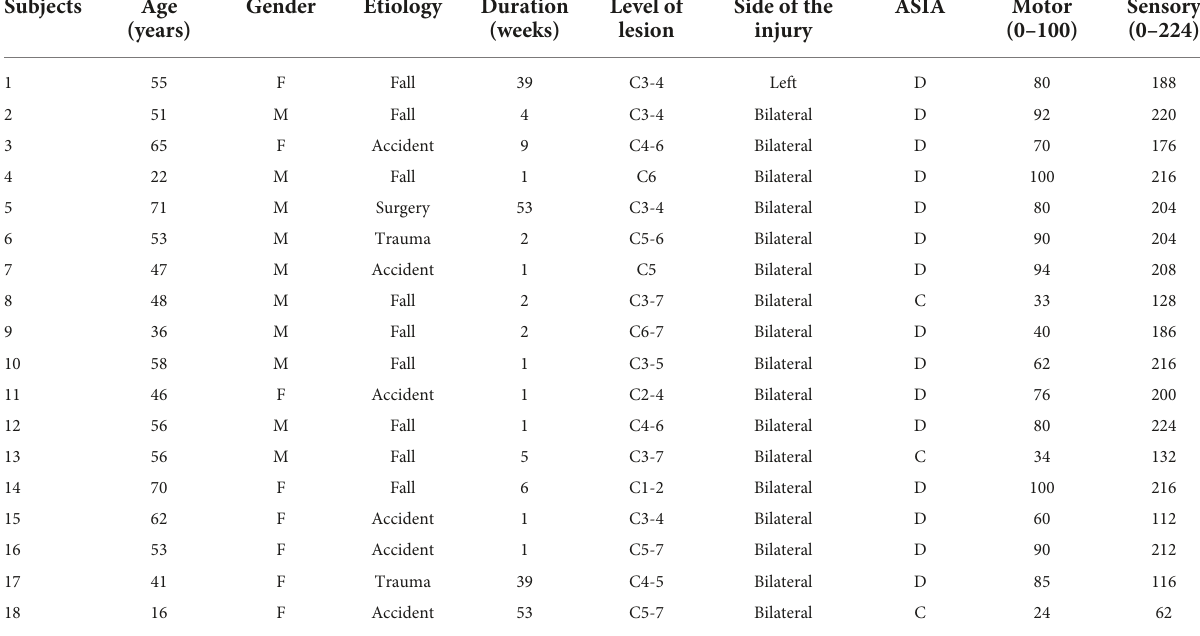
TABLE 1 Clinical data of ICCI patients.